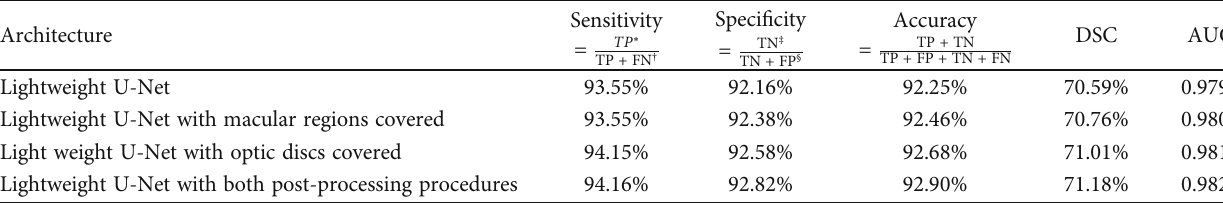
Table 1: Comparison of methods on the proposed dataset.